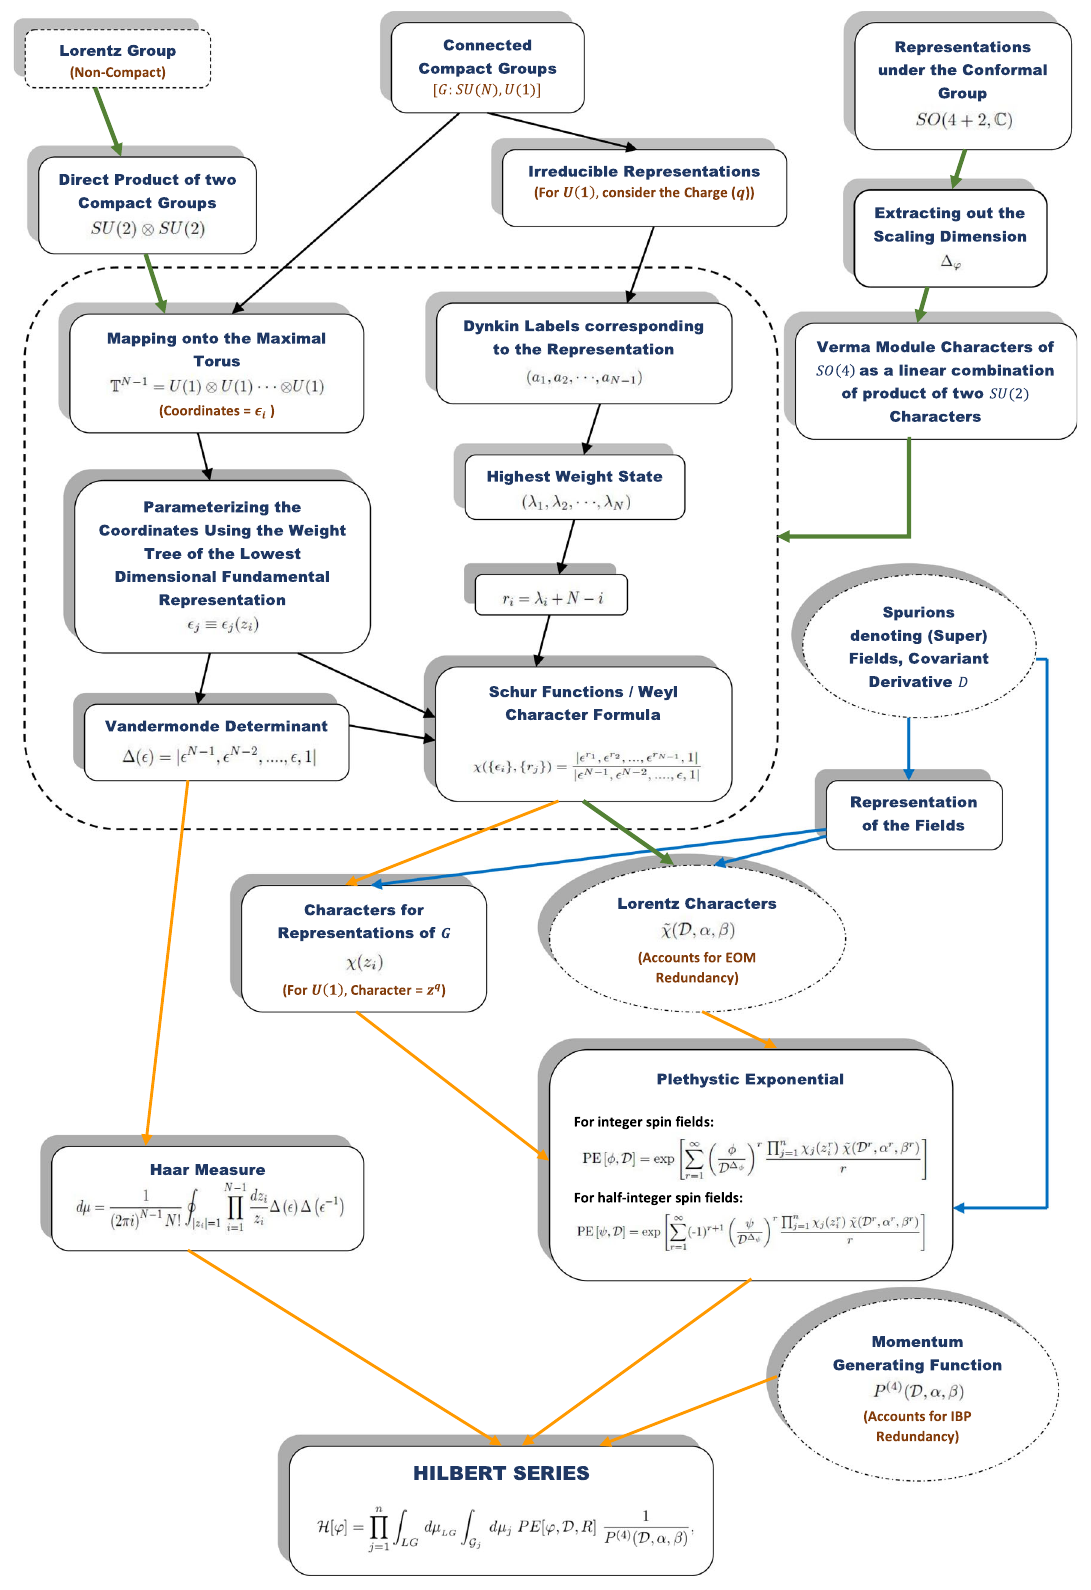
Fig. 4 Flow chart outlining the mathematical steps followed for computing the Hilbert